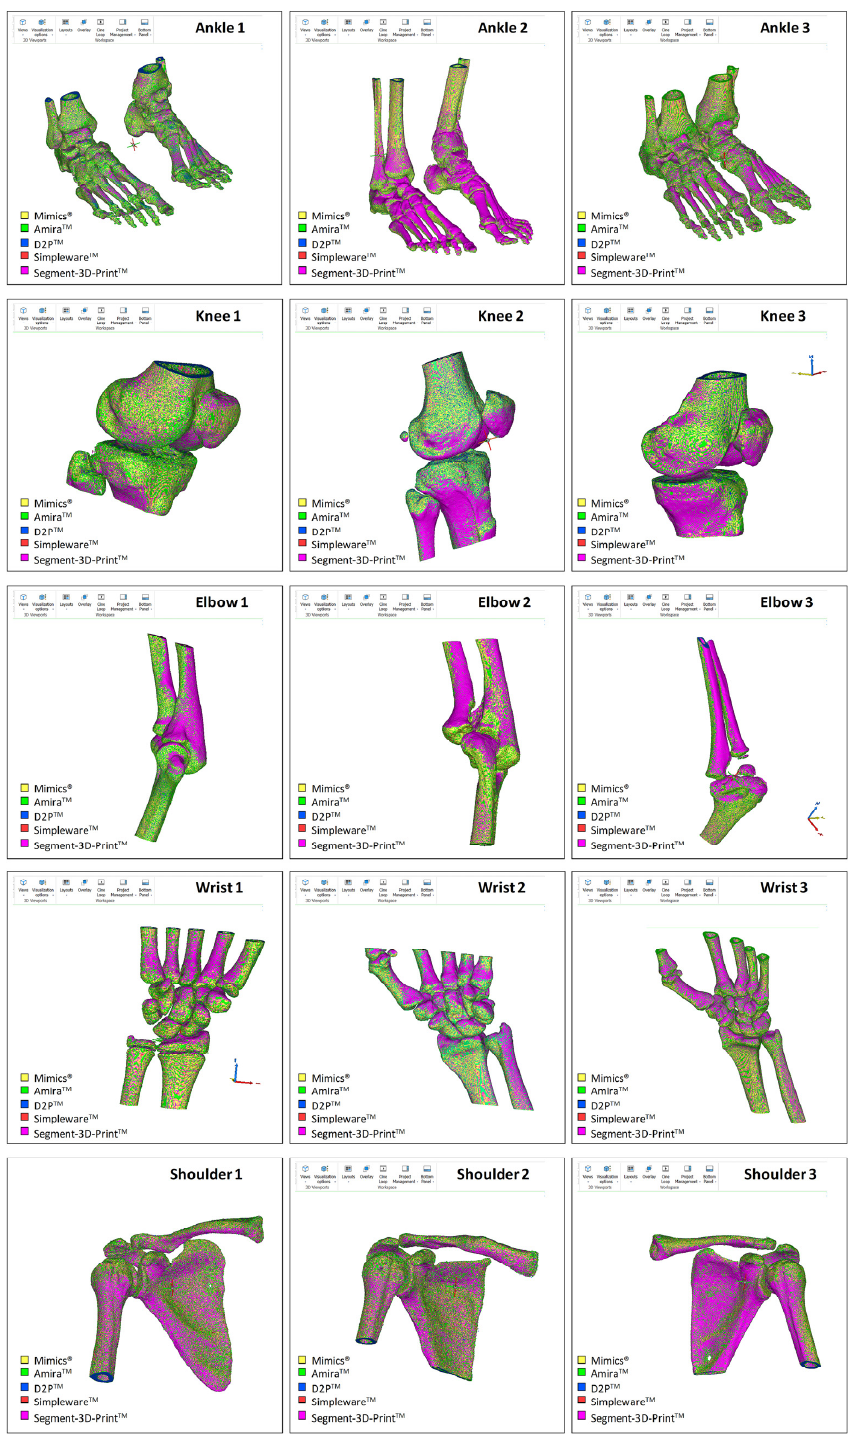
Figure 2. Superimposition of the resulting meshes from the five commercial software packages investigated; this is shown for each of the 15 DICOM files (three subjects for each of the five different anatomical areas). The STL models shown here for rough comparison were imported into Mimics for the present representation.